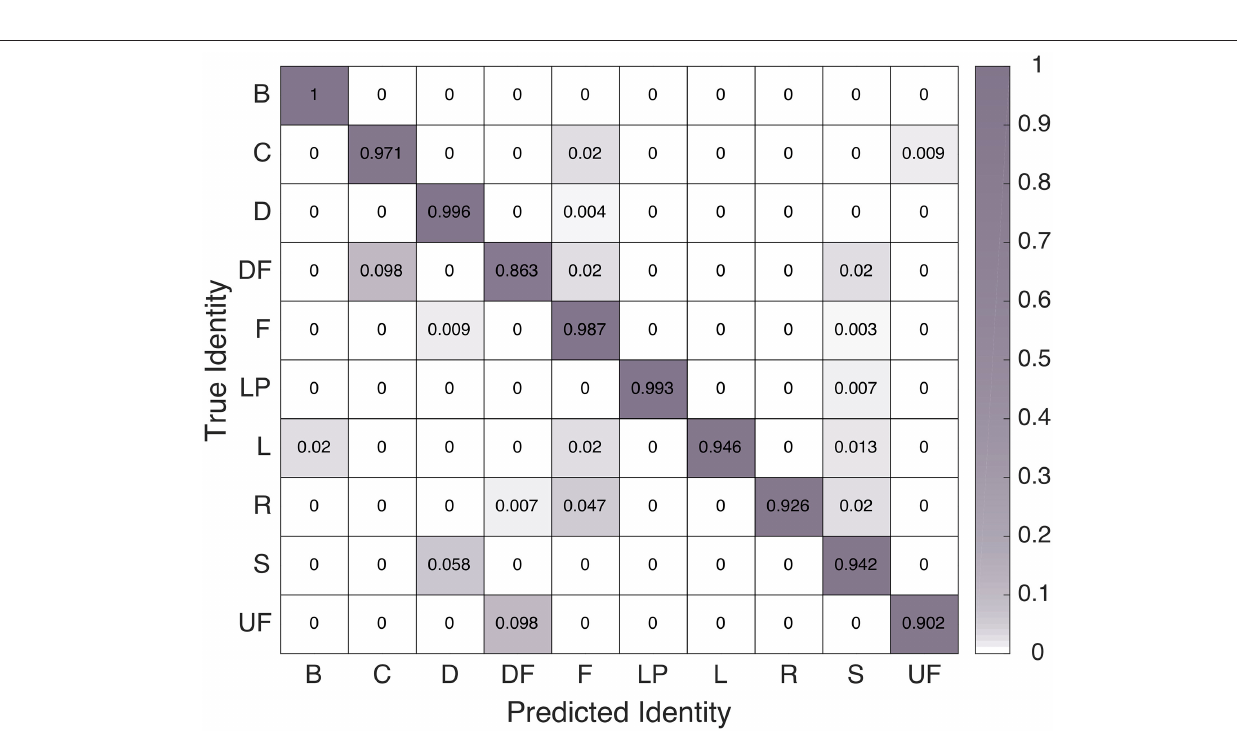
FIGURE 4 | Confusion matrix of SVM classifier performance on the test dataset.